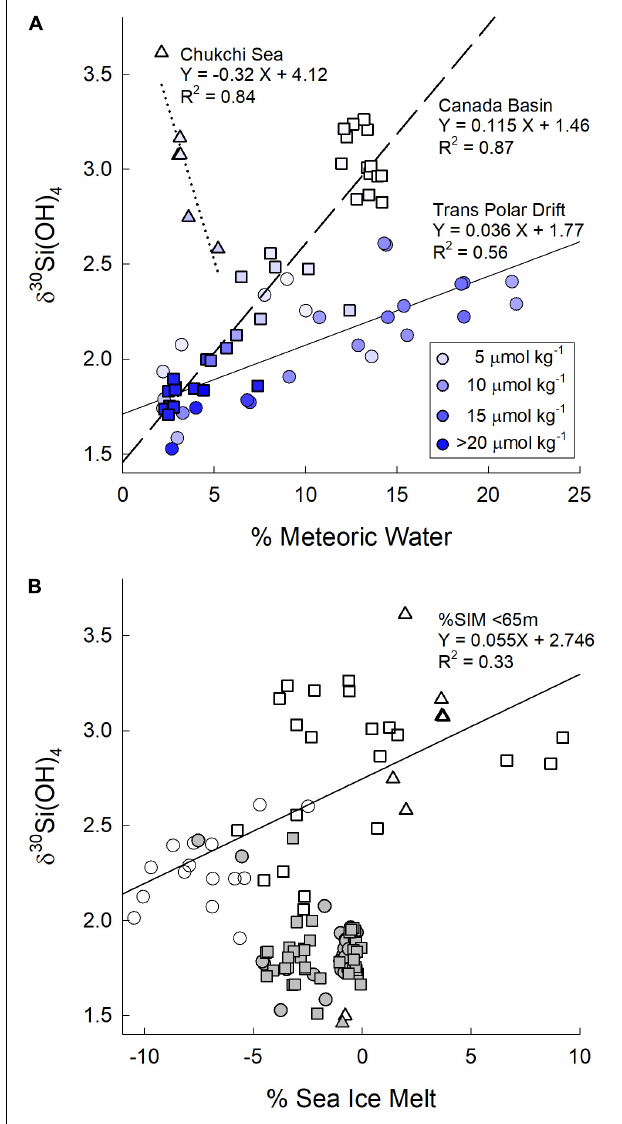
FIGURE 5 | (A) δ 30 Si(OH) 4 as a function of the % meteoric waters for surface waters in the transpolar drift (circles), the Canada Basin (squares), and in the Chukchi Sea (triangles). Shading of symbols is by silicic acid concentration as indicated in the legend. Solid, dashed, and dotted lines are linear regressions for the data in the transpolar drift, the Canada Basin and the Chukchi Sea, respectively. (B) δ 30 Si(OH) 4 as a function of the % sea ice melt for waters in the transpolar drift (circles), the Canada Basin (squares), and in the Chukchi Sea (triangles). Open symbols are for surface water < 65 m. Filled symbols are for waters from 65 to 500